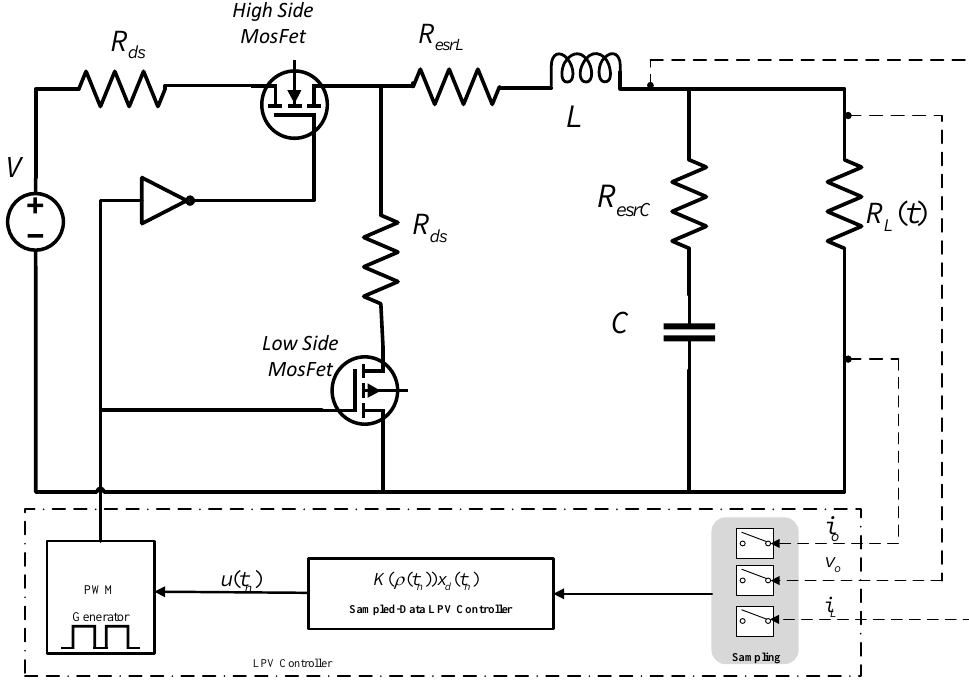
Figure 1. DC–DC buck converter topology with sampled-data LPV controller.